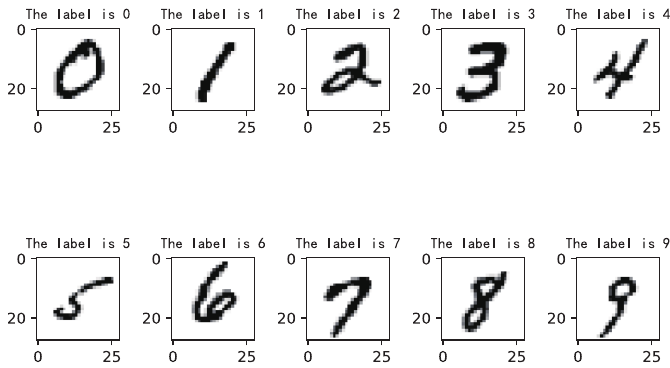
Figure 5. An example of some 0–9 numbers of MNIST parsed by